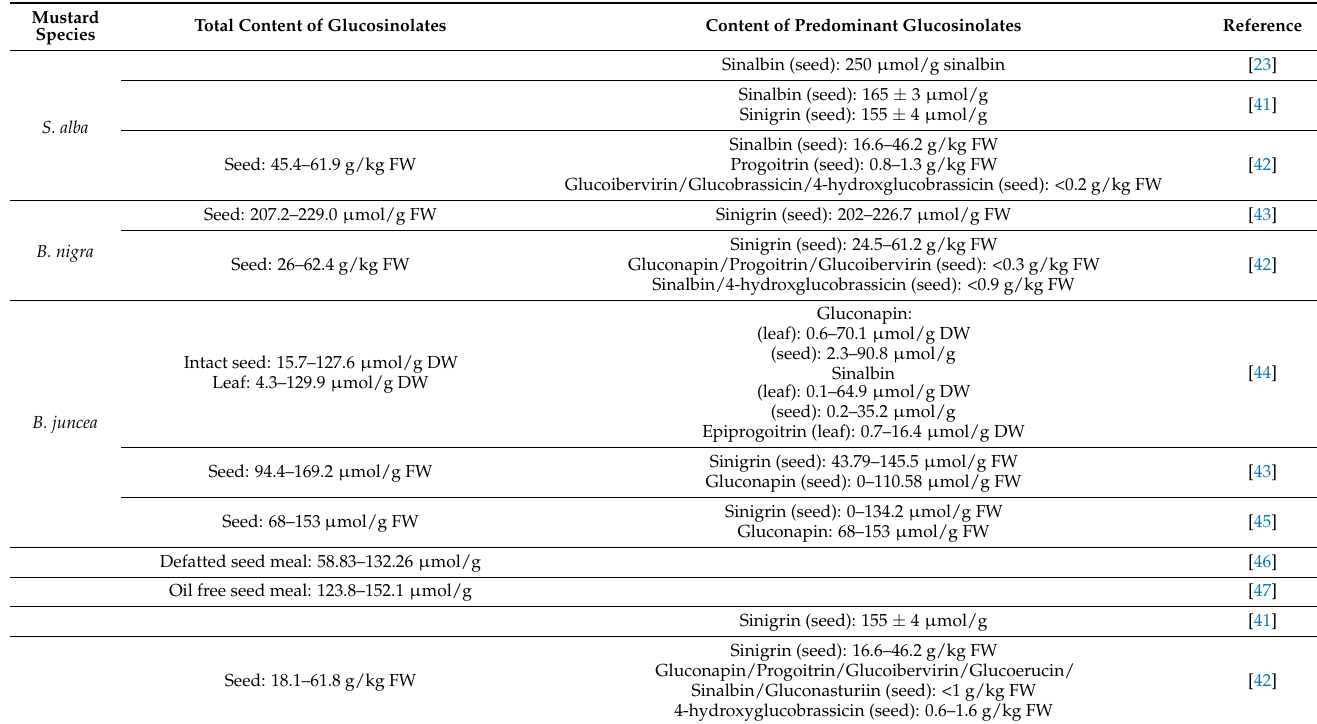
Table 2. Glucosinolate content in mustard